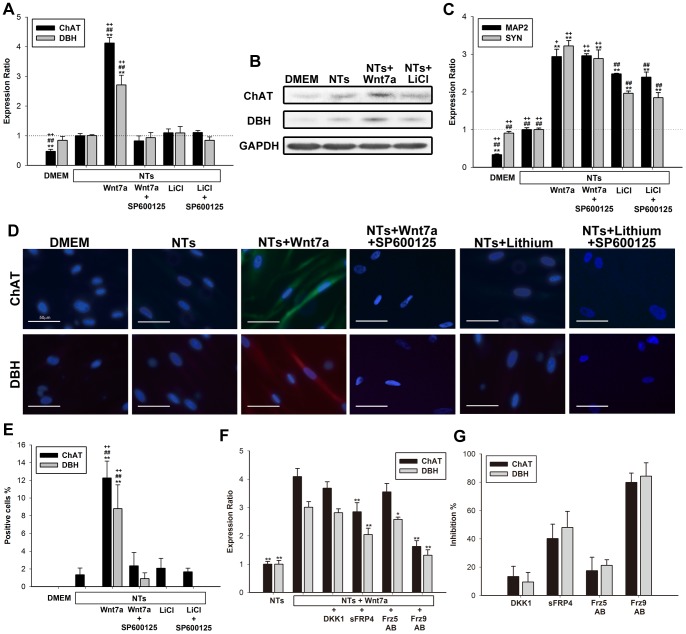
Neuronal specification by the non-canonical Wnt7a pathway in NT-induced hMSCs.(A) mRNA levels of ChAT and DBH were examined in NT-induced hMSCs, and SP600125 (15 µM) and Wnt7a (2 µg/ml) or LiCl (4 mM) were added to NT-induced hMSCs at the same time. Levels were normalized to those in the NTs control (set to 1.0). Wnt7a, but not lithium, stimulated mRNA levels in NT-induced hMSCs, and SP600125 totally inhibited Wnt7a-induced ChAT and DBH expressions. Data are presented as the mean ± SD of one triplicate experiment that was representative of the three independent experiments. * p<0.05, ** p<0.01 (all vs. NTs). #
p<0.05, ##
p<0.01 (all vs. NTs+Wnt7a+SP600125). +
p<0.05, ++
p<0.01 (all vs. NTs+LiCl+SP600125). (B) p4 NT-treated hMSCs were immunoblotted with ChAT, DBH, and GAPDH. The NT groups were treated with NTs for 14 days. The NTs+Wnt7a and NTs+lithium groups were treated with NTs for 7 days first, and then with NTs+Wnt7a or lithium for 7 days. DMEM groups served as controls. (C) Expression levels of MAP2 and SYN1 in NT-induced hMSCs with SP600125/Wnt7a or SP600125/LiCl are shown. SP600125 had no effect in MAP2 or SYN1 expression. Levels were normalized to those in NTs groups (set to 1.0). * p<0.05, ** p<0.01 (NTs vs. all groups). #
p<0.05, ##
p<0.01 (all vs. NTs+Wnt7a+SP600125). +
p<0.05, ++
p<0.01 (all vs. NTs+LiCl+SP600125). (D) p4 NT-treated hMSCs were stained with ChAT (green) and DBH (red). NTs groups were treated with NTs for 14 days. The NTs+Wnt7a and NTs+lithium groups were treated with NTs for the first 7 days and then with NTs+Wnt7a or lithium for the next 7 days. In inhibitory groups, SP600125 was added with Wnt7a or lithium in NT-induced hMSCs at the same time. DAPI (blue) was used as a counterstain. DMEM groups were used as controls. The white bar represents 50 µm. (E) Percentages of ChAT-positive cells and DBH-positive cells among all DAPI-positive cells calculated from (D). All data are presented as the mean ± SD. * p<0.05, ** p<0.01 (all vs. NTs). #
p<0.05, ##
p<0.01 (all vs. NTs+Wnt7a+SP600125). +
p<0.05, ++
p<0.01 (all vs. NTs+LiCl+SP600125). (F) As described in "Materials and Methods", mRNA levels of ChAT and DBH were examined by a qPCR. Levels were normalized to those in NTs groups (set to 1.0). * p<0.05, ** p<0.01 (NTs+Wnt7a vs. all groups). (G) Percentages of inhibition calculated from (E). Data are presented as the mean ± SD of one triplicate experiment that was representative of three independent experiments.